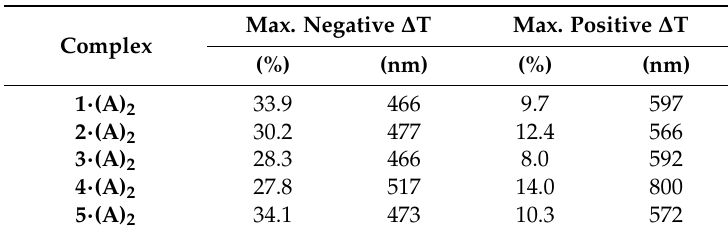
Table 2. Maximum transmission change ( Δ T/%) of the compounds 1 ∙ (A) 2 – 5 ∙ (A) 2 , dissolved in toluene, before and after the exposure to 100 ppm CO for 10 min.